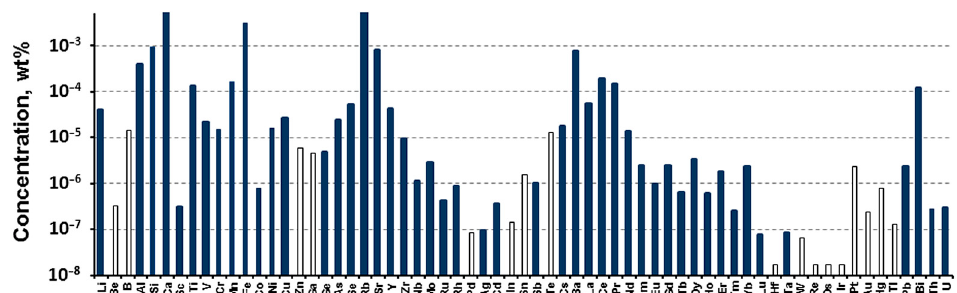
Figure 2. Impurity concentrations determined by ICP-MS in the Mg produced by electrolysis. Here and after the empty bars indicate the limits of determination (LD) of ICP-MS analysis.